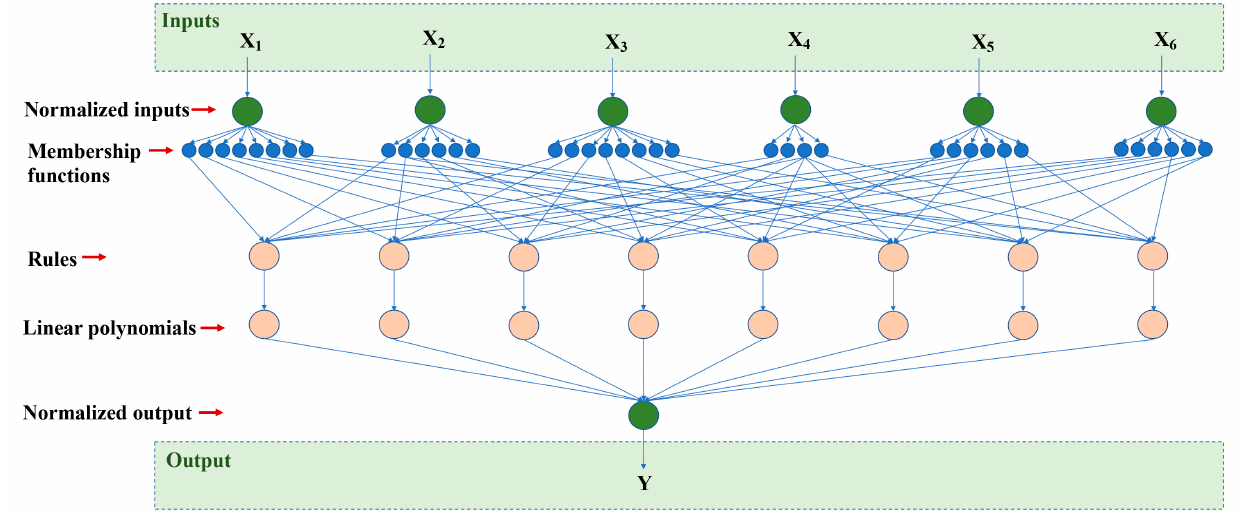
Figure 6. The architecture of the proposed ANFIS.